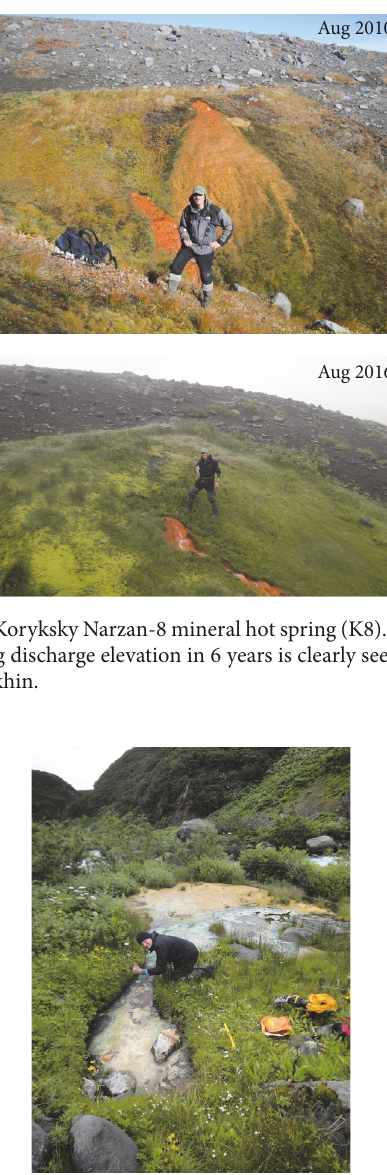
Figure 30: Hot mineral springs on a Northern slope of Koryaksky Volcano. K1, K2, and K8: Koryaksky Narzan 1, 2, and 8, correspond- ingly; IS, Isotovsky. July 2011. Photo by A. V. Kiryukhin.